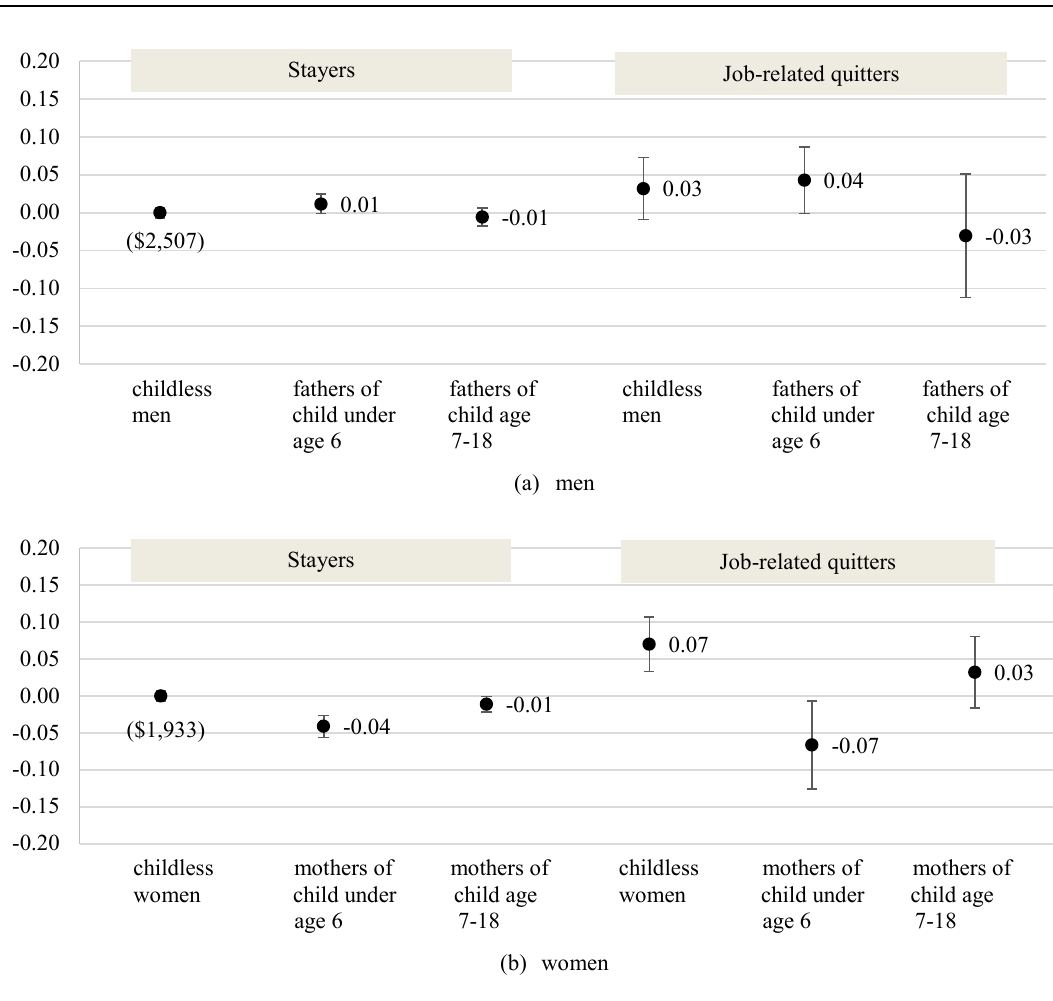
Figure 1: Differences in logged monthly earnings between childless stayers and other workers in the pre-recession